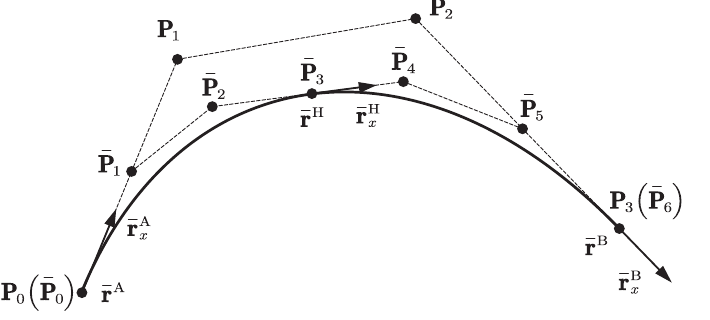
Figure 4. Segmentation of ALE-RANCF